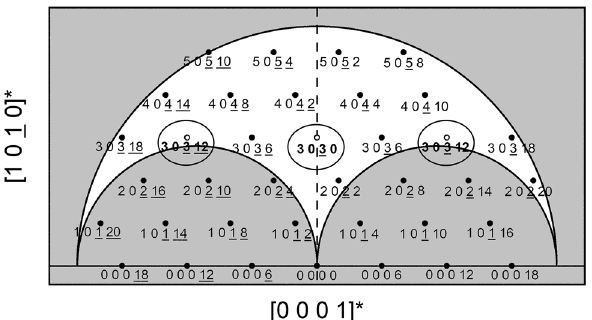
Figure 4. Cross-section of reciprocal space spanned by the [1010]* and [0001]* zone axes for the allowed reflections of calcite. The open circles indicate peaks measured in this study. The outer shaded region corresponds to the Cu Kα 1 limiting sphere and the two inner shaded regions correspond to transmission geometry conditions.